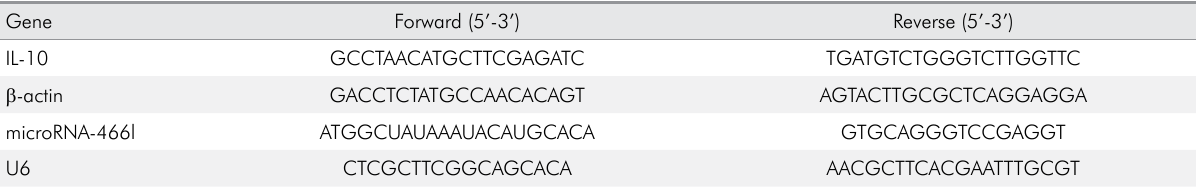
Table 1. The sequences of primers used in RT-qPCR analyses.